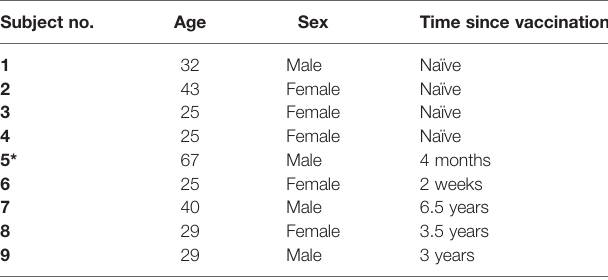
TABLE 1 | Description of study participants with time since receiving the 13- valent pneumococcal conjugate vaccine (PCV13). Subject no.